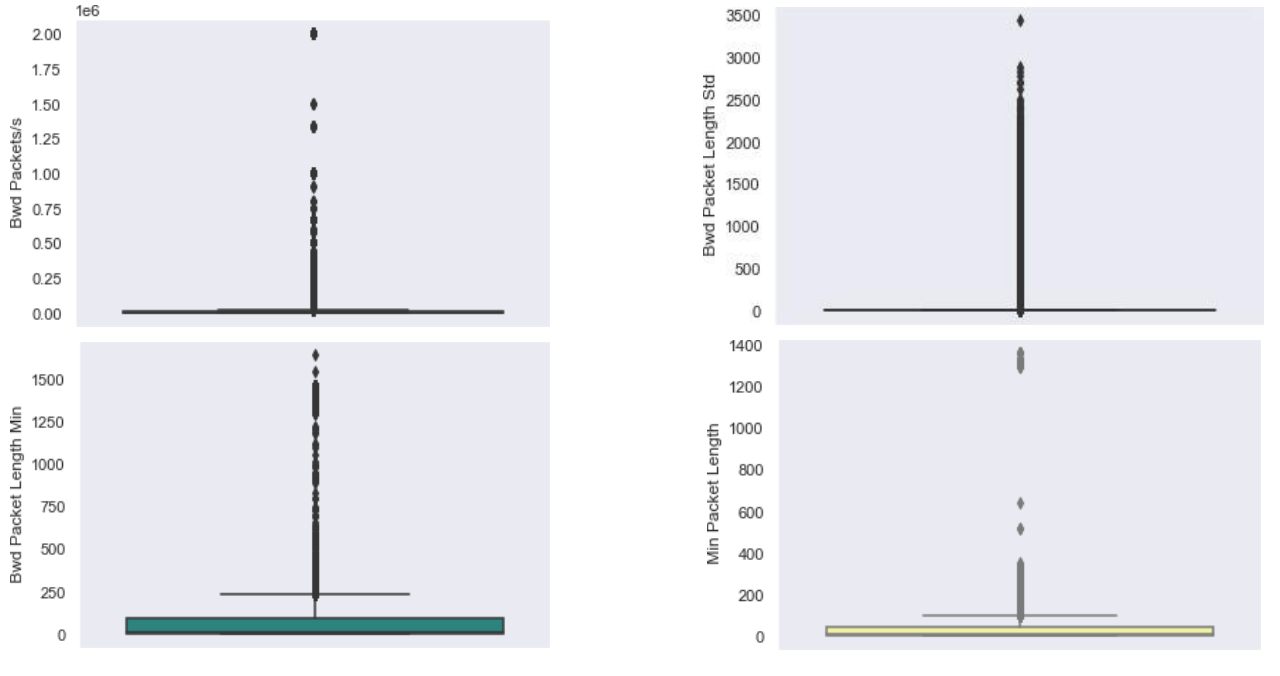
Figure 5. Boxplots of outliers/anomalies.